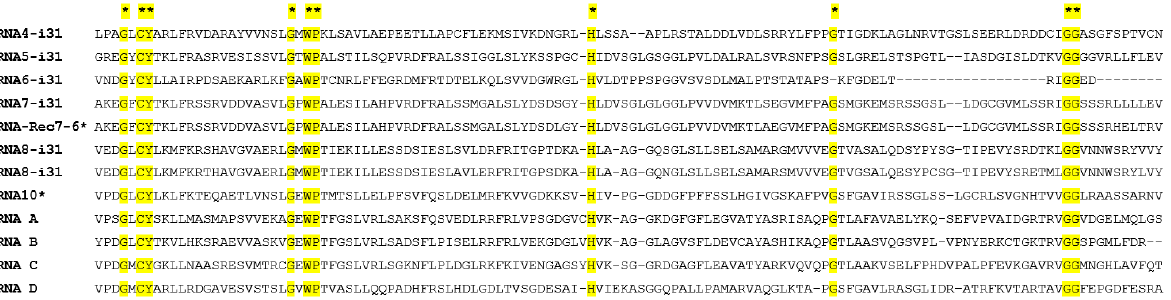
Figure 4. Multiple alignment of the conserved domains identified in selected GaJV-1 and CaJV-1 proteins. Fully conserved amino acids are highlighted in yellow and marked by an asterisk above the alignment.